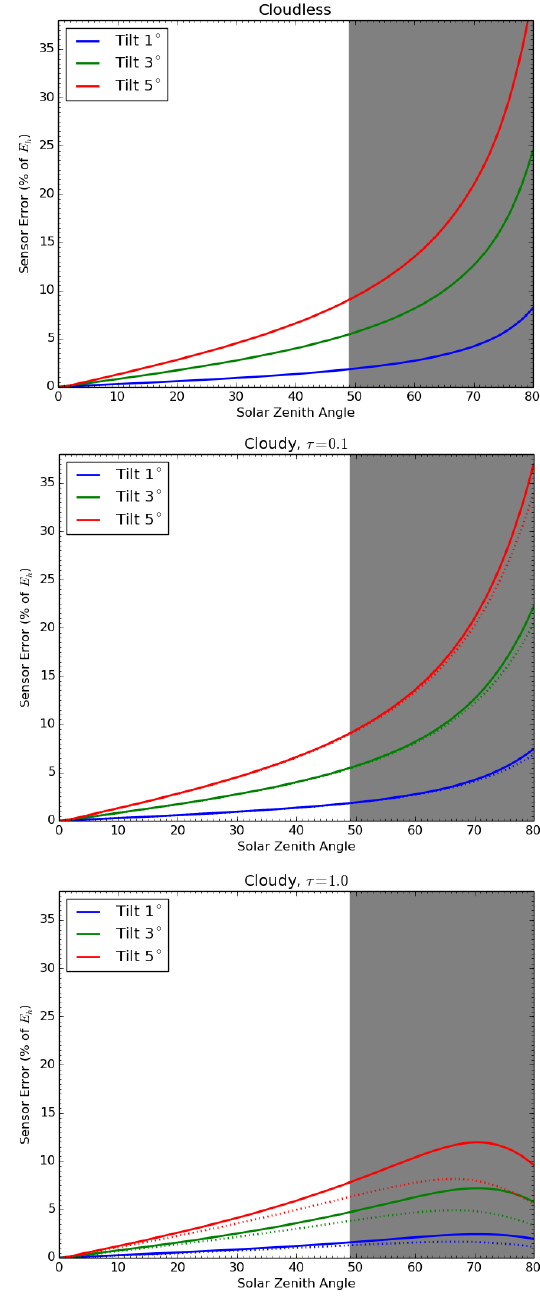
Figure 2. Total sensor error, η Eq. (9), for the full solar shortwave spectrum (global), for a sensor tilted directly toward the sun. The same sky conditions are shown as in Fig. 1: one cloudless (top) and two cloudy cases. In the middle and bottom plots, solid (dotted) lines denote liquid (ice) water cloud results. The grey shaded area begins at 49 ◦ , representing the lowest observable solar zenith angle at Summit Station, Greenland (latitude 72.58 ◦